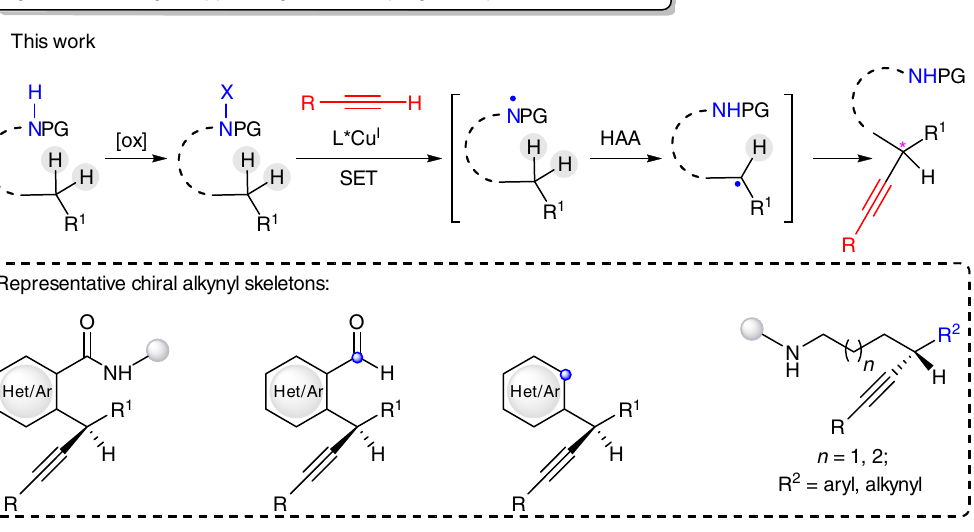
Fig. 1 Sonogashira-type enantioselective oxidative cross-coupling of C( sp 3 ) − H bonds with terminal alkynes. a Previous ionic-type dehydrogenative coupling of C( sp 3 ) — H bonds adjacent to nitrogen. b Our proposal: tandem HAA and copper-catalyzed Sonogashira-type coupling. c Amide-directed enantioselective coupling of C( sp 3 ) − H bonds with terminal alkynes. HAA hydrogen atom abstraction, [ox] oxidant, SET single-electron